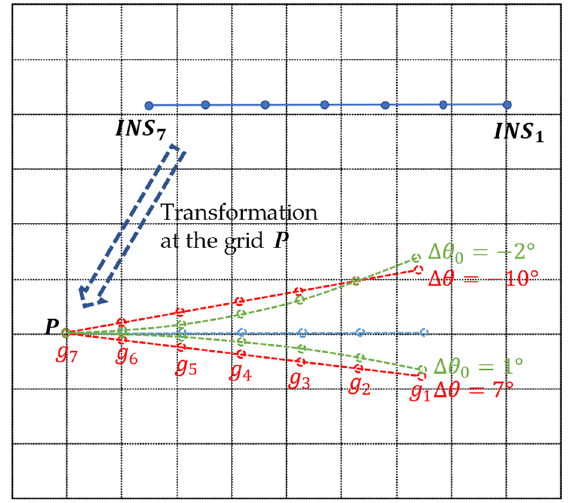
Figure 2. Transform the INS track.